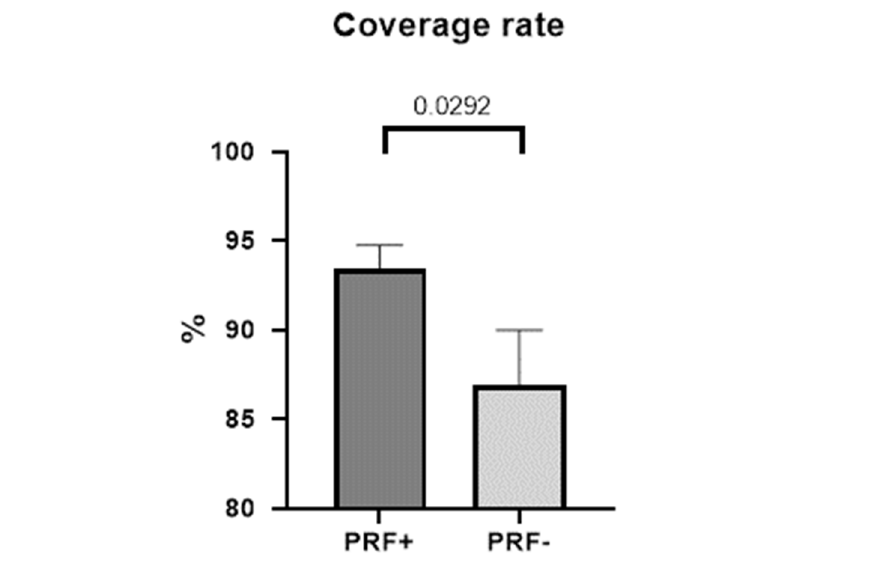
Figure 4. Coverage rate in percent in the PRF and non-PRF groups.